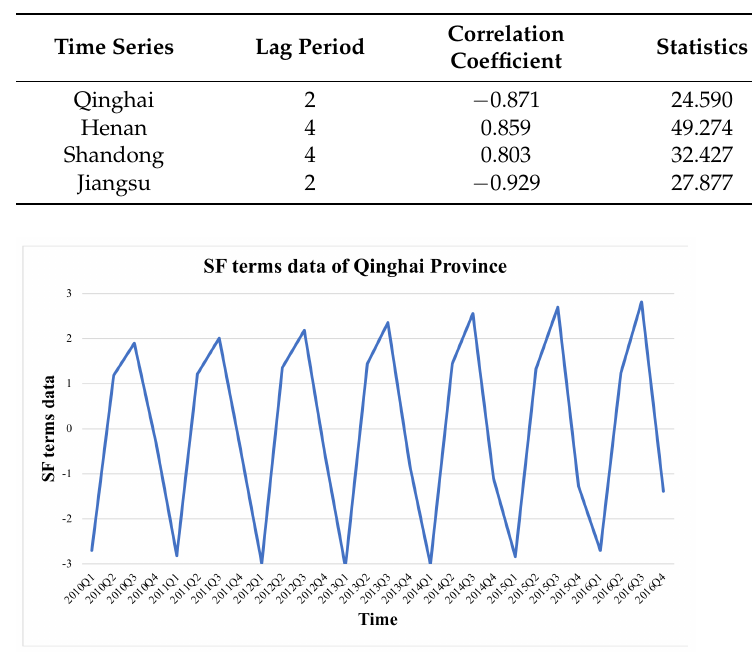
Table 8. Seasonality trait test results for SF.